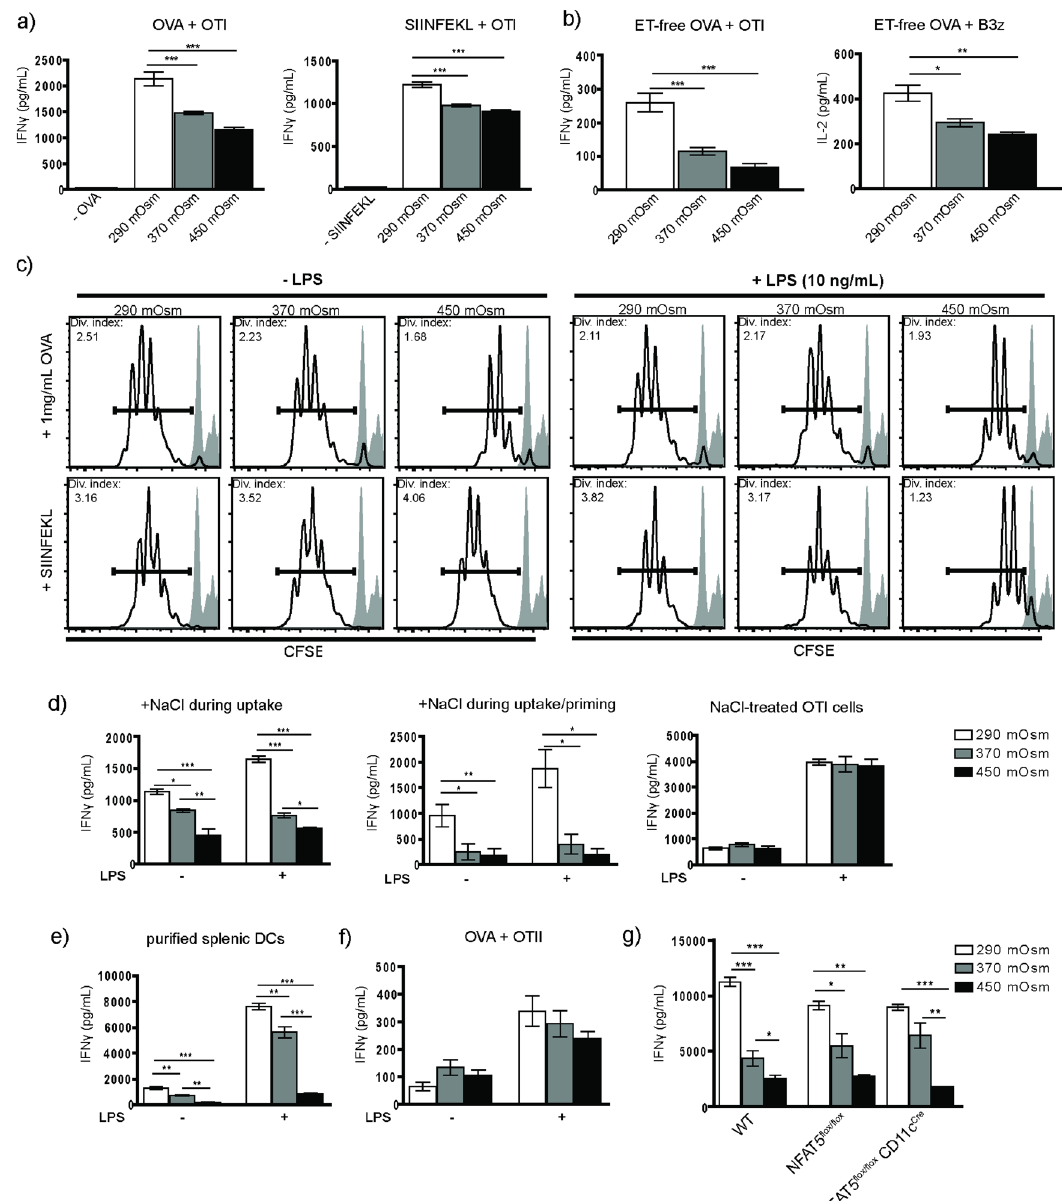
Figure 1. Hyperosmotic microenvironment inhibits CD8 + T cell activation. ( a ) BMDCs raised in isotonic or hypersomotic conditions (290 mOsm, 370 mOsm and 450 mOsm) were incubated with OVA (0,5 mg/ mL; left graph, n = 8) or SIINFEKL peptide (1 µ g/mL, right graph, n = 4), without or with LPS (10 ng/mL) for 2 hours, followed by overnight (17 hours) co-incubation with OTI cells. ( b ) Using the same approach, OVA was substituted by endotoxin-free OVA (1 mg/mL, left graph, n = 8), and B3z cells were used instead of OTI cells (right graph, n = 4). ( c ) CFSE-labeled OTI cells were incubated with OVA-primed BMDCs for 96 hours and analyzed by flow cytometry for CFSE dilution as a direct measure of OTI proliferation (representative histograms, n = 4). ( d ) BMDCs developed in isotonic conditions were exposed to normosmolar or indicated hyperosmolar microenvironment during ET-free OVA uptake (left graph, 2 hours; n = 4); continuously during ET-free OVA uptake and co-incubation with OTI cells (middle graph, n = 4) and used in T cell activation assay as described. In a separate experiment, solely OTI cells were treated with NaCl-rich medium for 2 hours upon sorting and used in the BMDC/OVA assay as described (right graph, n = 4). ( e ) Purified CD11c + dendritic cells gained by magnetic separation from spleens of C57BL/6 mice were exposed to isotonic or NaCl-enriched media for a period of 6 hours and used in ET-free OVA/OTI T cell activation assay (n = 4). ( f ) OTII cells were co-incubated with ET-free OVA- loaded BMDCs from different osmolarities, without or with (10 ng/mL) LPS stimulus (n = 5). ( g ) BMDCs derived from bone marrows of CD11c-cell specific NFAT5-deficient mice were developed in isotonic or NaCl-hypertonic conditions and used in the cross-priming OVA/OTI assay as previously described (n = 4). IFN- γ and IL-2 were measured from cell culture supernatants. Statistical data are expressed as mean ± SEM and are representative of at least two independent experiments ( * p ≤ 0.05, ** p ≤ 0.01, *** p ≤